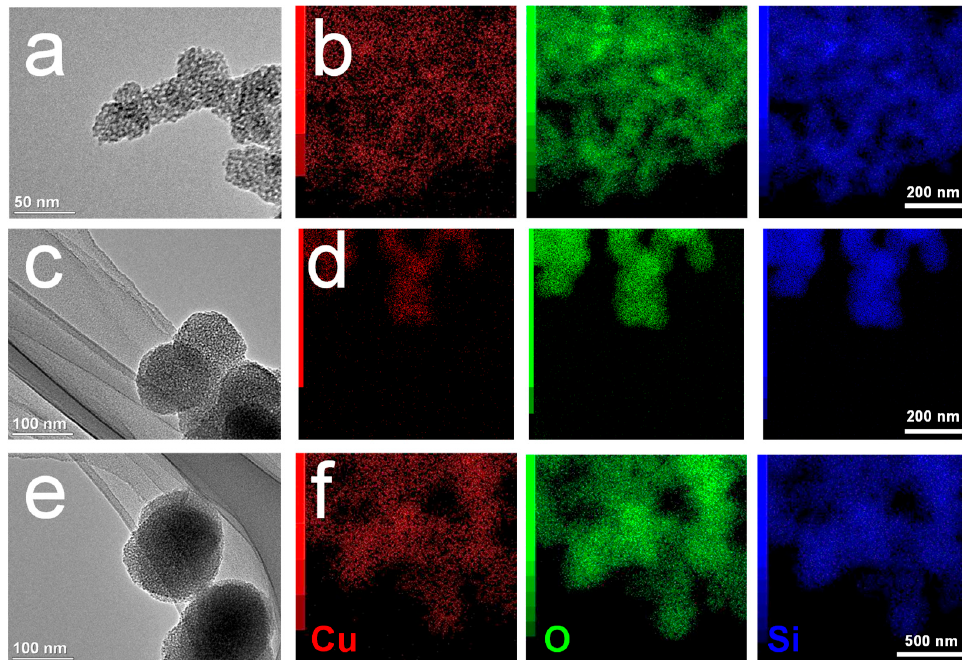
Figure 1. TEM ( a , c , e ) and STEM-EDX ( b , d , f ) images of MS-Cu nanospheres with different particle size. MS-Cu-1 ( a , b ), MS-Cu-2 ( c , d ), MS-Cu-3 ( e , f ).